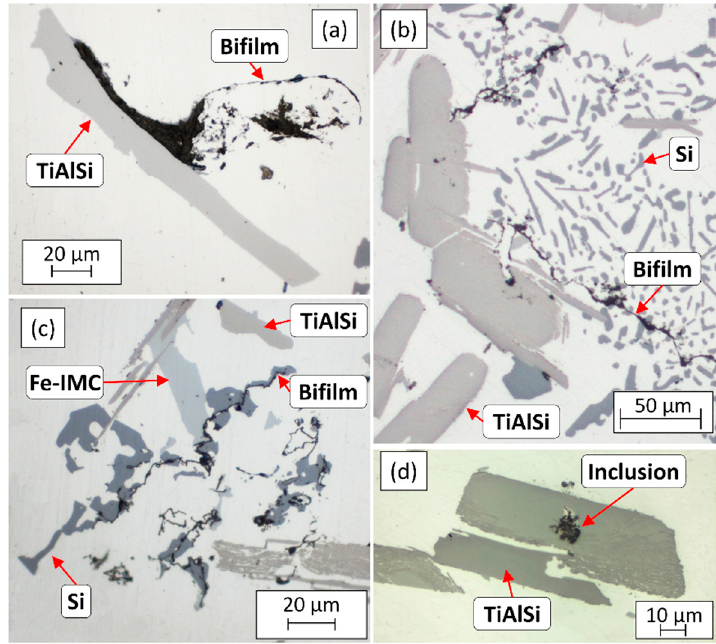
Figure 11. ( a – d ) Optical micrographs of inhomogeneities found in the sediment formed during the A1 experiment.